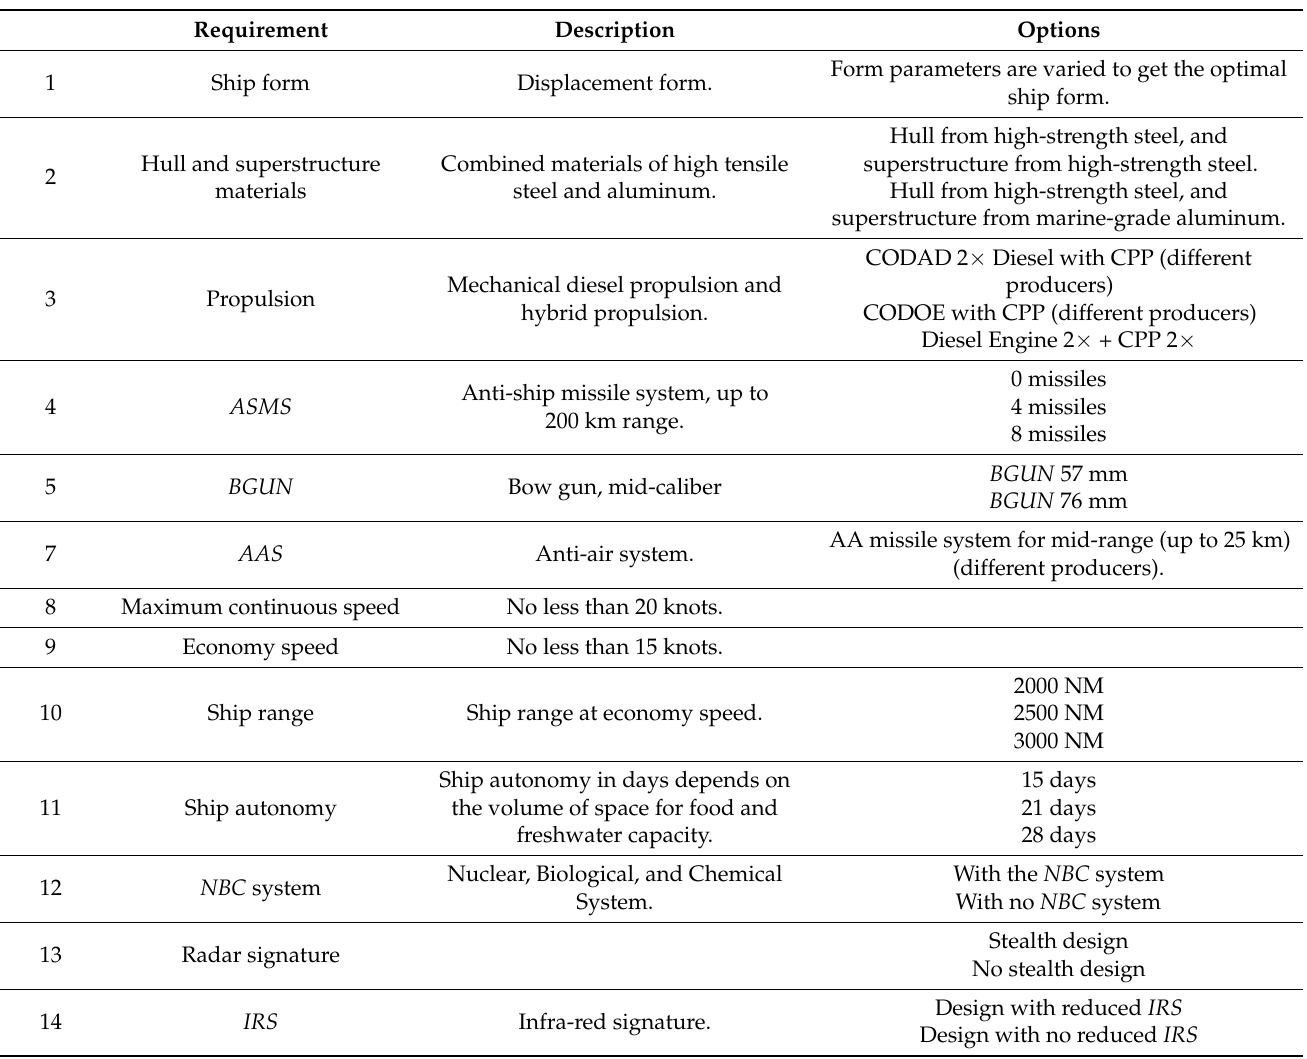
Table 1. Concept design